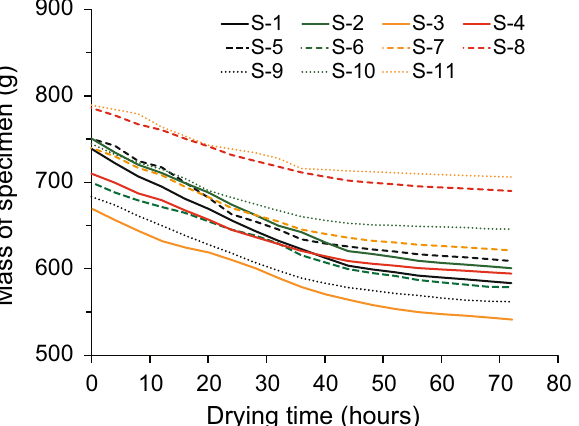
Figure 6. Change in mass with drying time of specimens dried for 72 h. Very little change in mass is observed after 65 h.